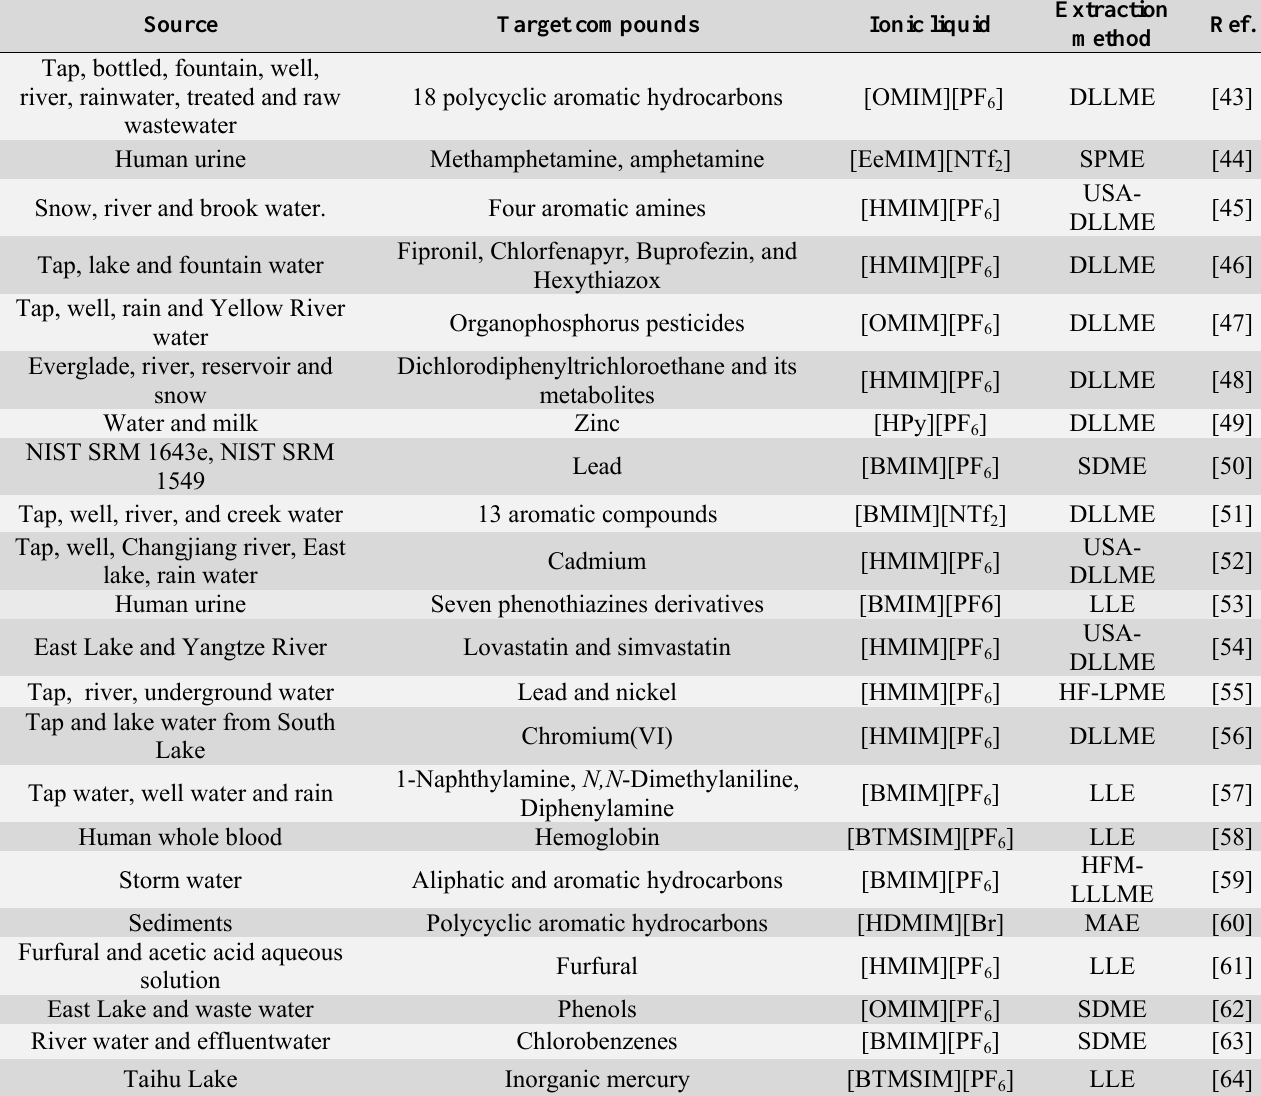
Table 3. Extraction of organic and metal compounds from environmental